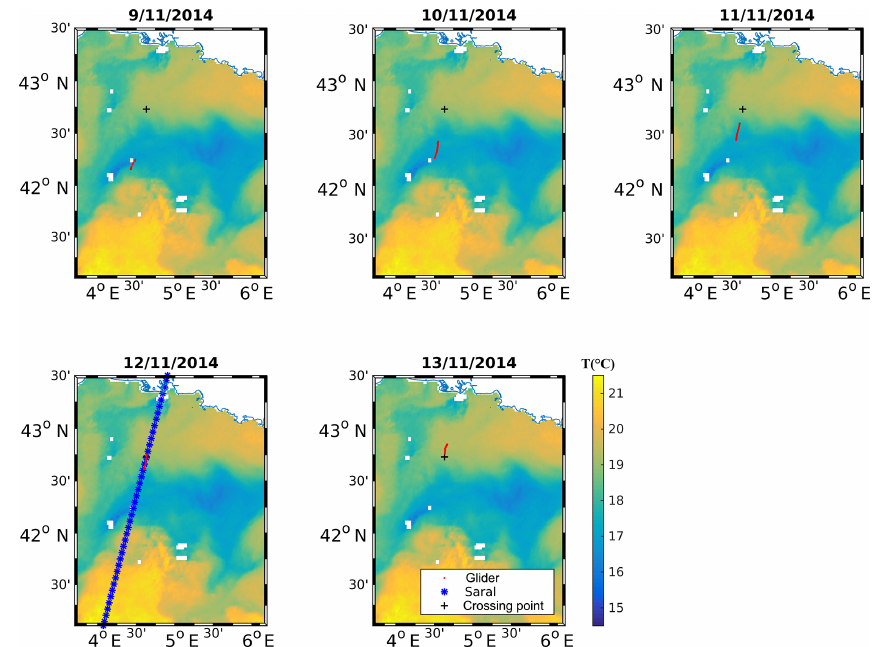
Figure 8. Five-day series of satellite SST maps for the period 9–13 November. The glider position is shown each day (in red), the SARAL– glider crossing position on 12 November (in black), and the SARAL track passing on 12 November 2014. Daily SST fields at 0.02 ◦ resolution from